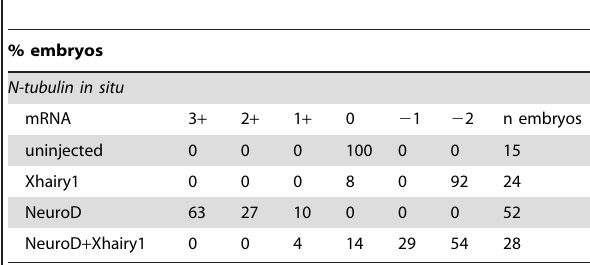
Table 5. Effect of Xhairy1 on NeuroD